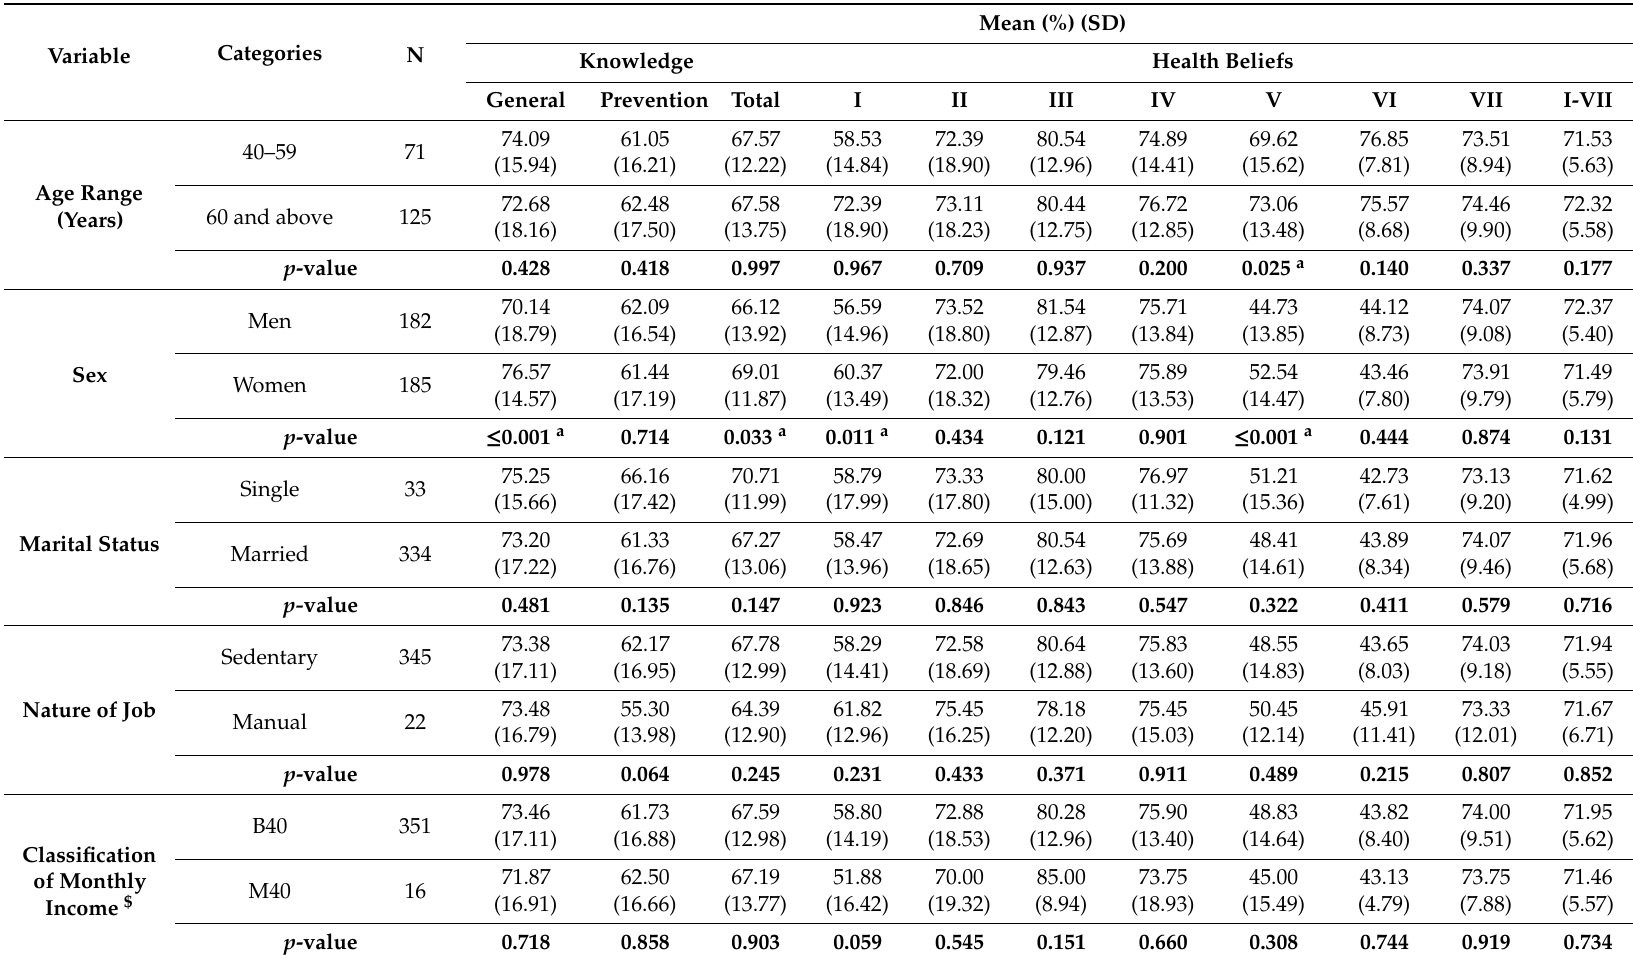
Table 3. Comparison of osteoporosis knowledge and beliefs with socio-demographic